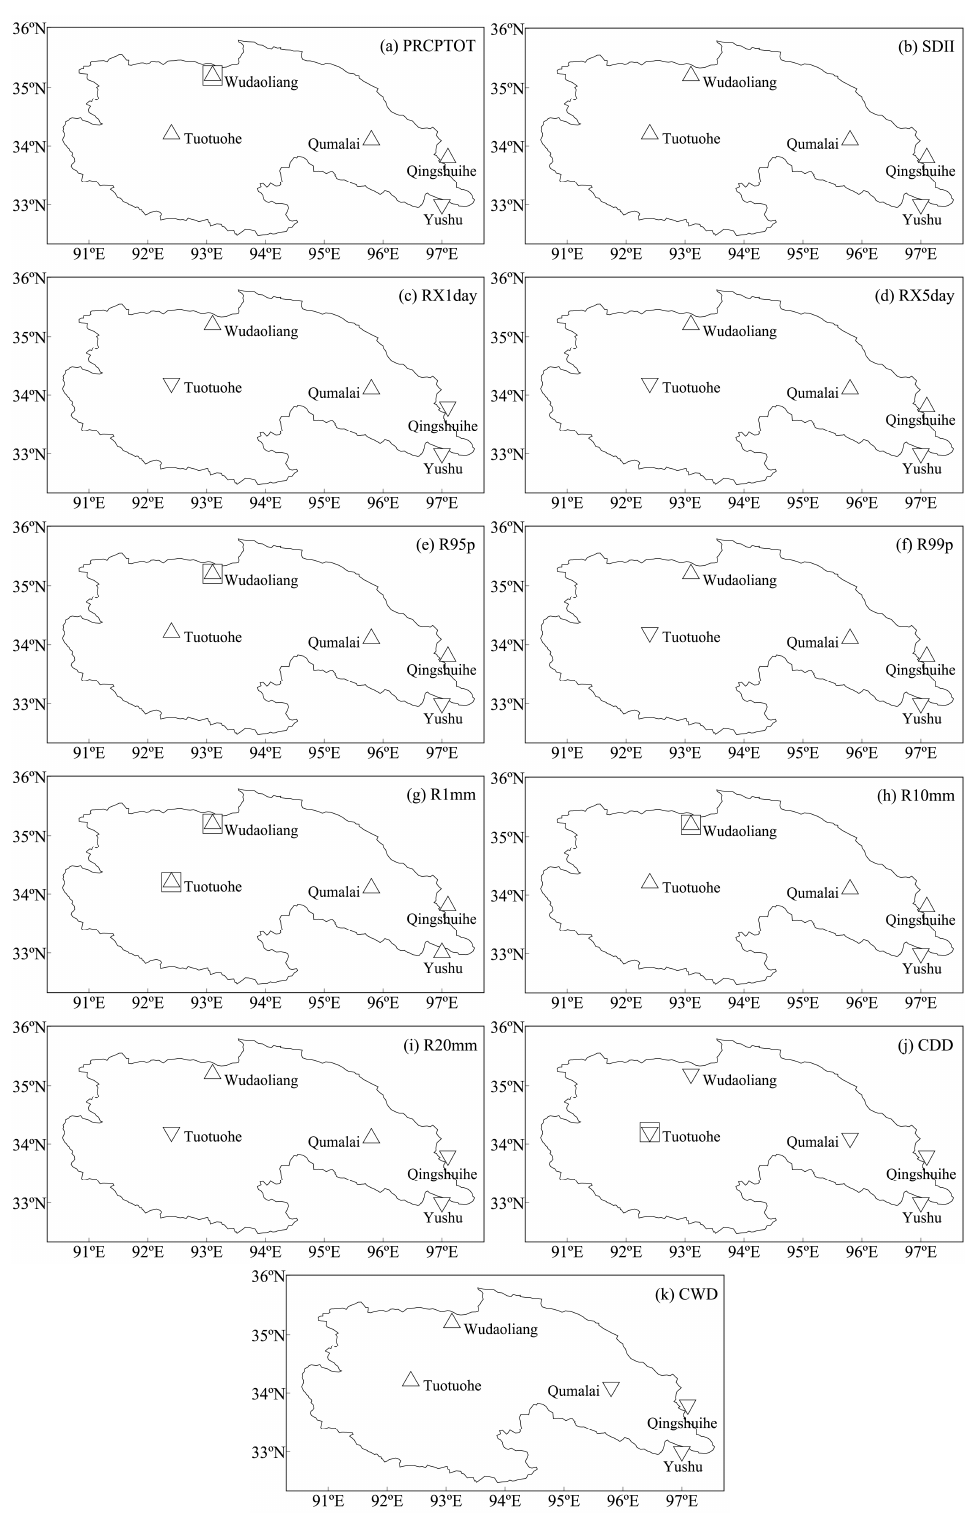
Figure 3. Spatial patterns of trends in the extreme precipitation indices over the SRYR during 1960–2016 for ( a ) PRCPTOT, ( b ) SDII, ( c ) RX1day, ( d ) RX5day, ( e ) R95p, ( f ) R99p, ( g ) R1mm, ( h ) R10mm, ( i ) R20mm, ( j ) CDD, and ( k ) CWD. Increasing (decreasing) trends are marked by upright triangles (inverted triangles), while statistically significant trends (at a 5% significant level) are marked by square